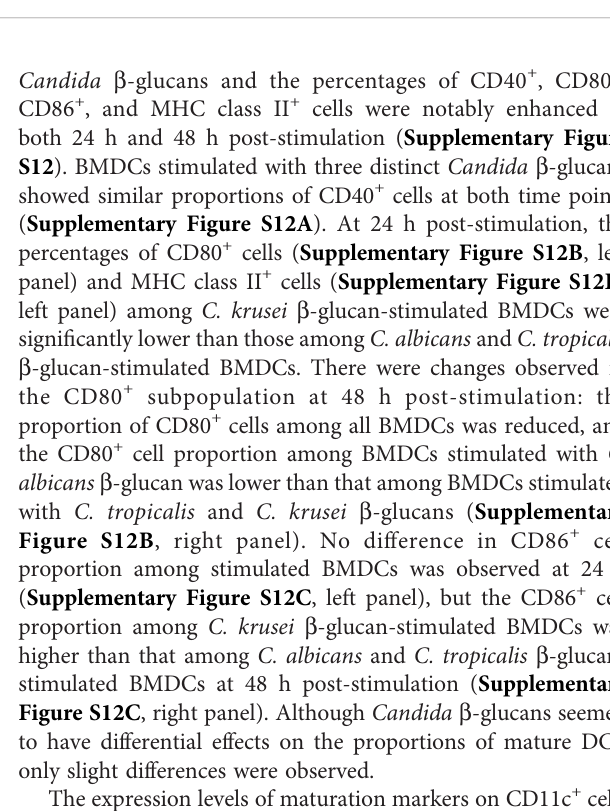
FIGURE 2 | HSQC spectrum of C. krusei b -glucan (500 MHz, DMSO-d 6 + TFA-d 1 ). C. krusei b − glucan 50 mg was dissolved in DMSO-d 6 (2.07 ml) and TFA-d 1 (0.11 ml) then 0.5 mL of the solution was withdrawn to perform the HSQC experiment with 500 MHz NMR spectrometer at room temperature. The spectrum indicated a highly homogeneous b -(1,3)-glucan without b